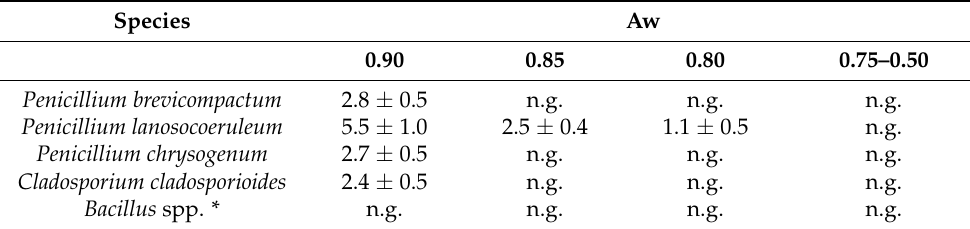
Table 9. Growth of different microbial species isolated from cocoa powder and chocolate in Malt Agar and * Plate Count Agar with different Aw and